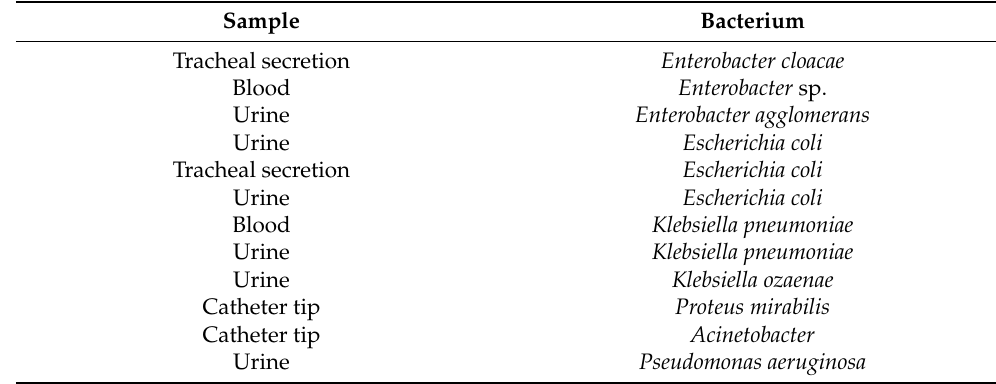
Table 5. Hospital bacteria samples from different biological materials used in screening of maceration, infusion, Soxhlet, and ultrasound